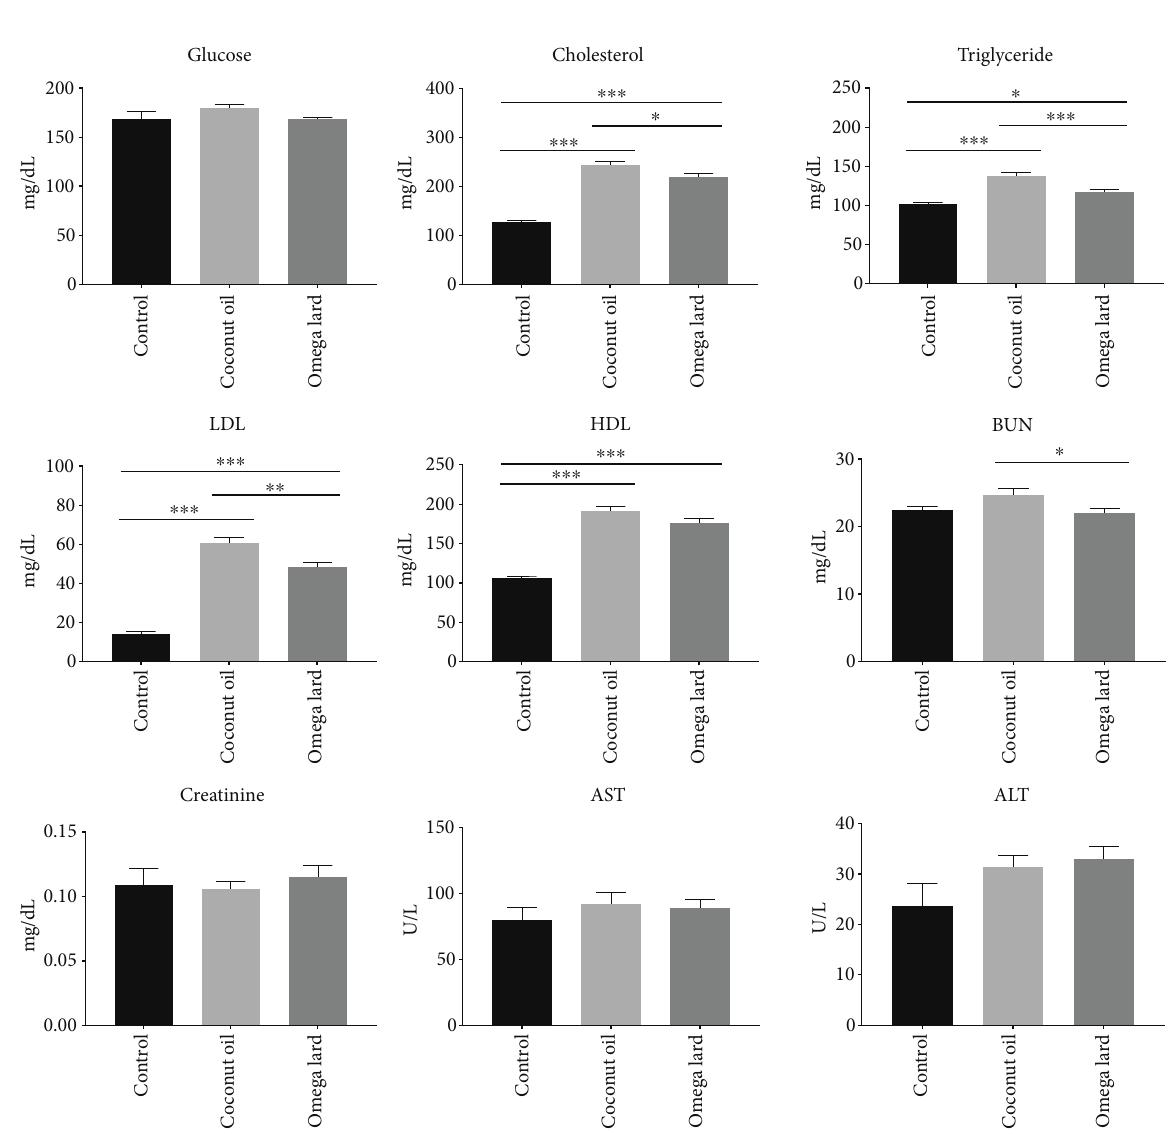
Figure 2: Di ff erences in serum lipid pro fi le and liver and kidney function enzymes. The di ff erences in the levels of glucose, cholesterol, triglycerides, LDL, HDL, BUN, creatinine, ALT, and AST are shown. Control, coconut oil, and omega lard refer to the control, coconut oil-fed, and omega lard-fed groups, respectively. All parameters were analyzed using serum samples collected at the end of the experiment (four weeks). Data are presented as mean ± SEM . The number of mice was 8, 7, and 8 in the control, coconut oil-fed, and omega lard-fed groups, respectively. The serum level of each parameter is shown on the y -axis and the groups are indicated on the x -axis. Asterisks indicate signi fi cant di ff erences between groups ( P < 0 : 05